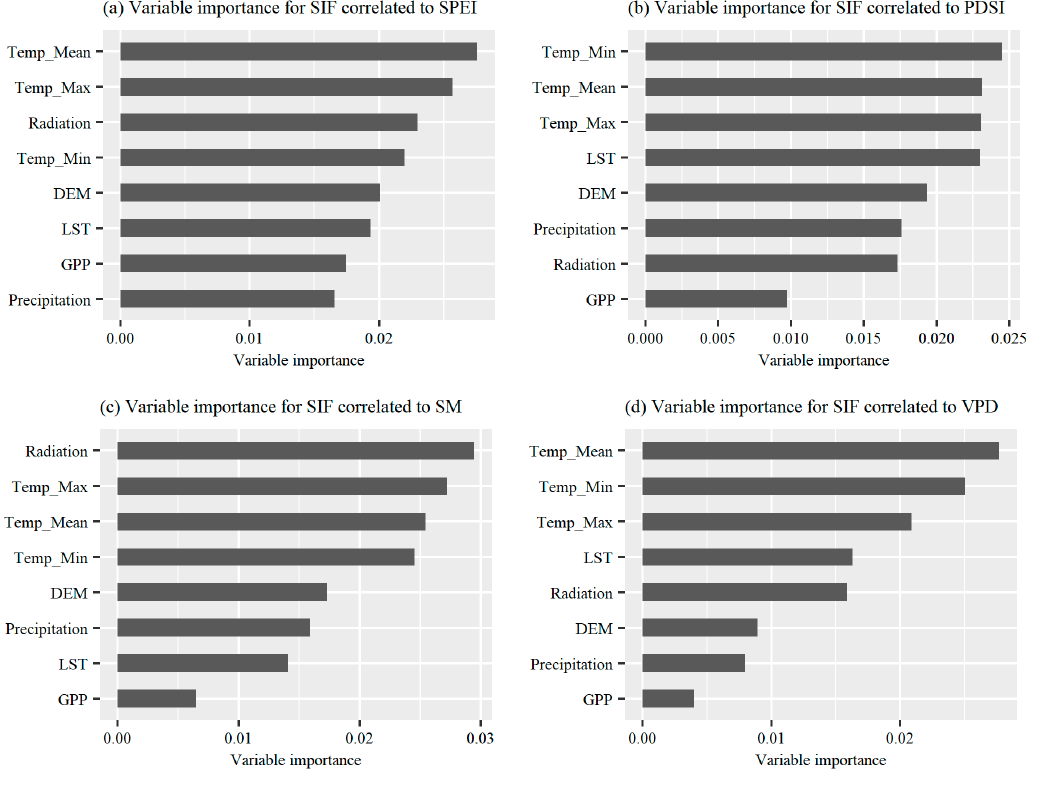
Figure 11. Importance of the eight factors for interpreting the correlation between satellite SIF and ( a ) SPEI, ( b ) PDSI, ( c ) SM, and ( d ) VPD. Temp_Mean, Temp_Max, Temp_min, and LST represent the mean temperature, maximum temperature, minimum temperature, land surface temperature, respectively.